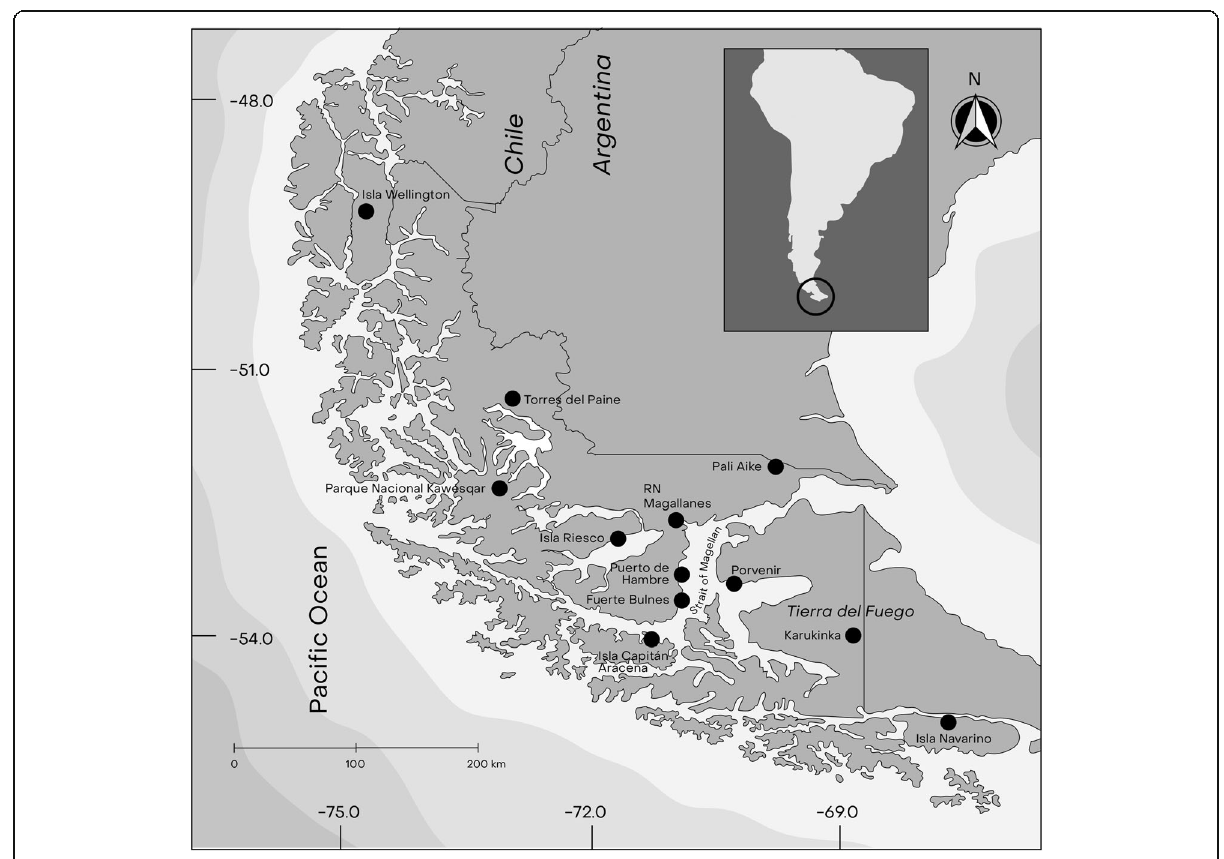
Fig. 1 Map of the study area including the mainland and islands of the southern Patagonia of Chile. PN = Parque Nacional, RN = Reserva Nacional